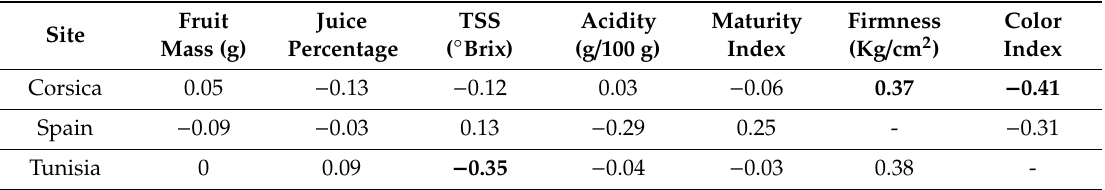
Table 3. Spearman rank correlation coe ffi cients between FDF and fruit parameters measured in February in orange cultivars cultivated in Corsica, Spain and Tunisia (values in bold are statistically